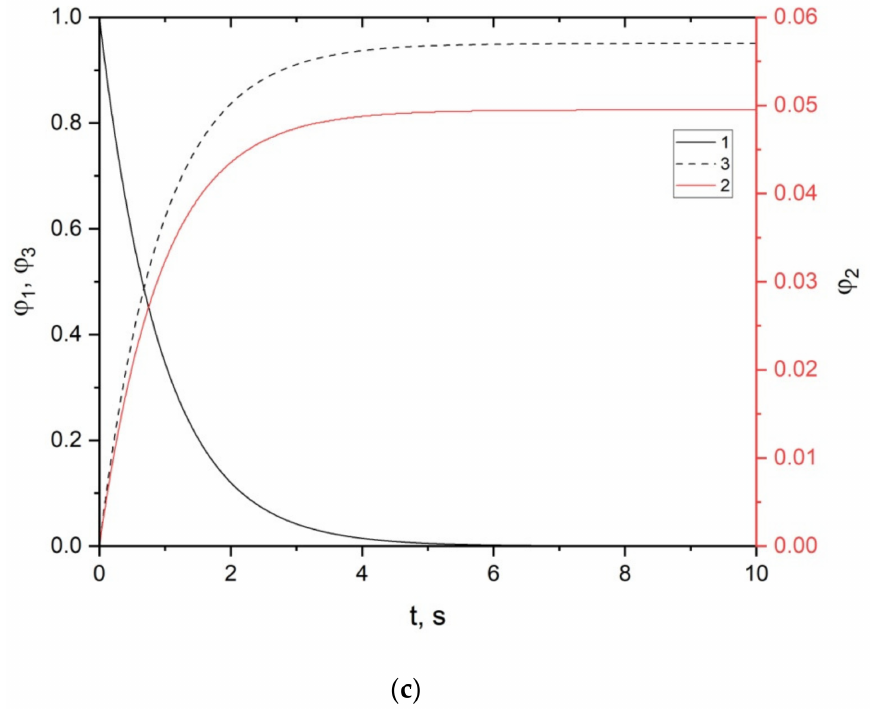
Figure 6. Dependences of volume fractions of phases on time for firebrand with a transverse dimension of 10 cm: 1: dry organic matter; 2: soot particles; 3: gas mixture; ( a ) dispersion coefficient